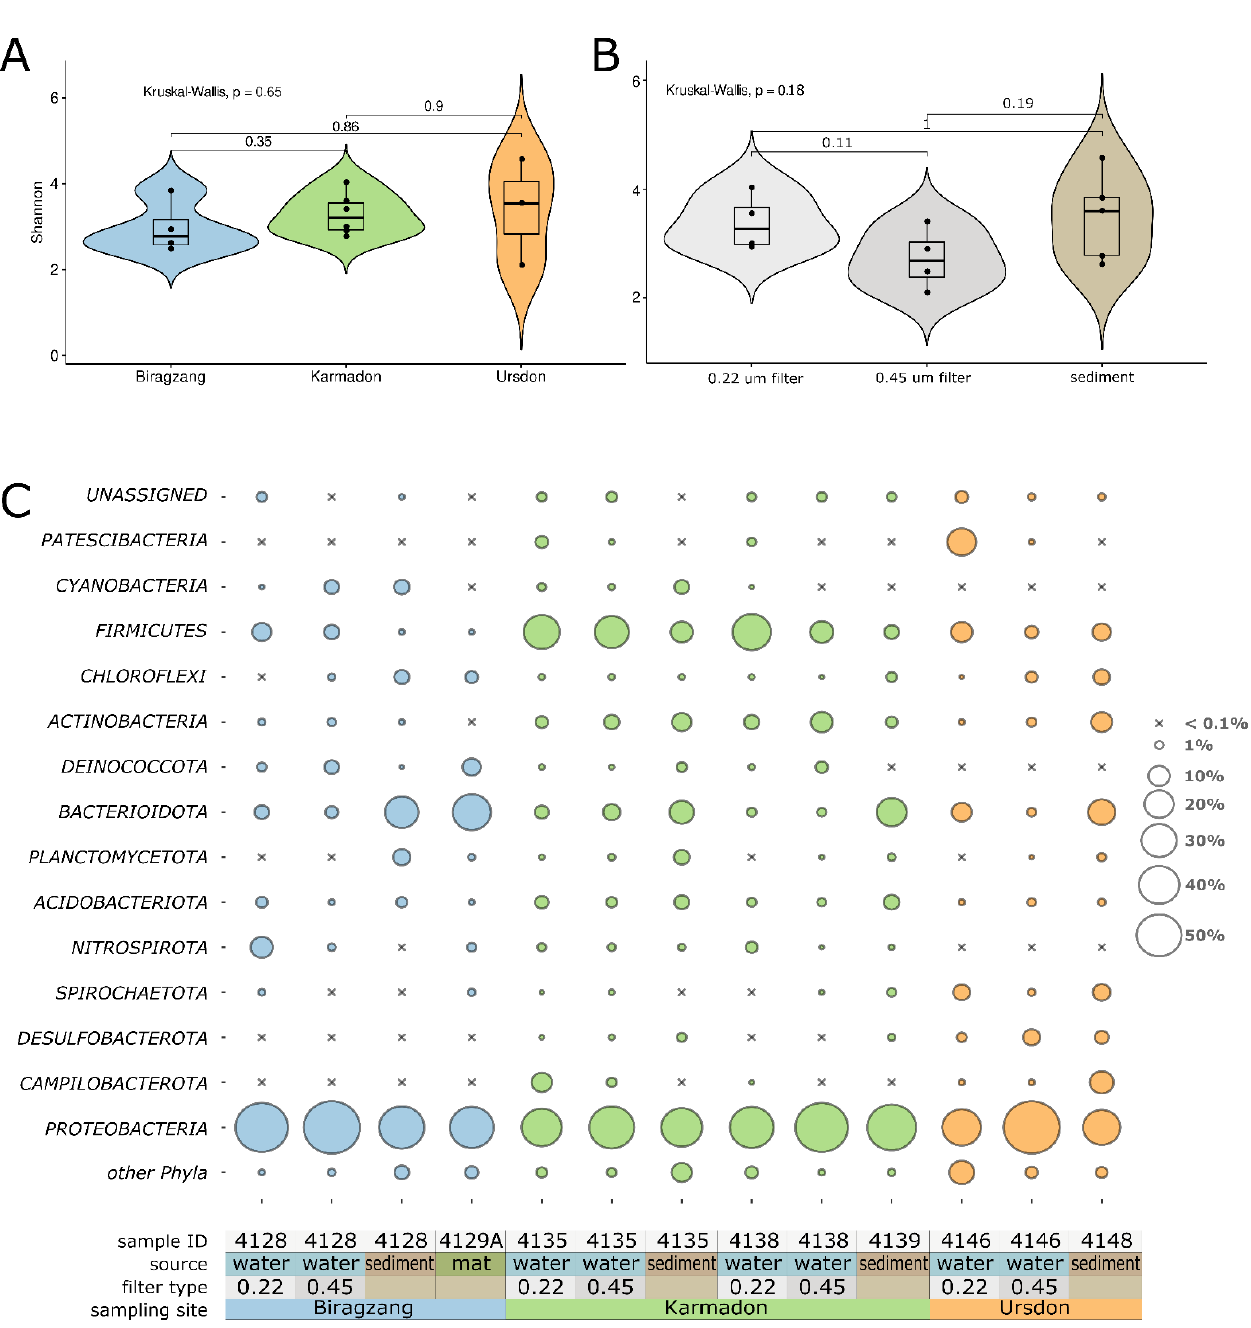
Figure 2. Alpha diversity and taxonomic composition of thermophilic microbial communities of North Ossetia-Alania: ( A ) violin plots of Shannon indexes compared between sampling sites; ( B ) violin plots of Shannon indexes compared between community fractions, retained 0.22 µm, 0.45 µm and sediments; ( C ) bubble plot of phyla abundances in each sample.